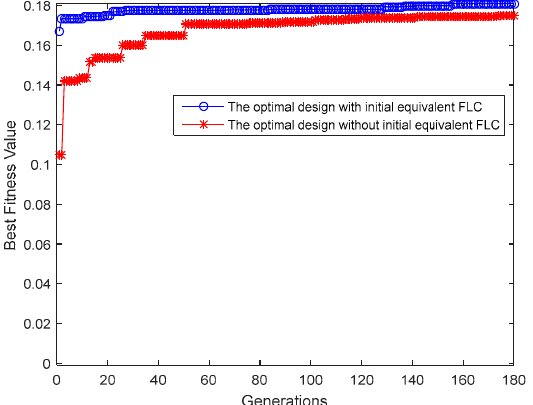
Figure 7. The control surface view of the equivalent fuzzy PID controller ( ( ) e t = 0.266).